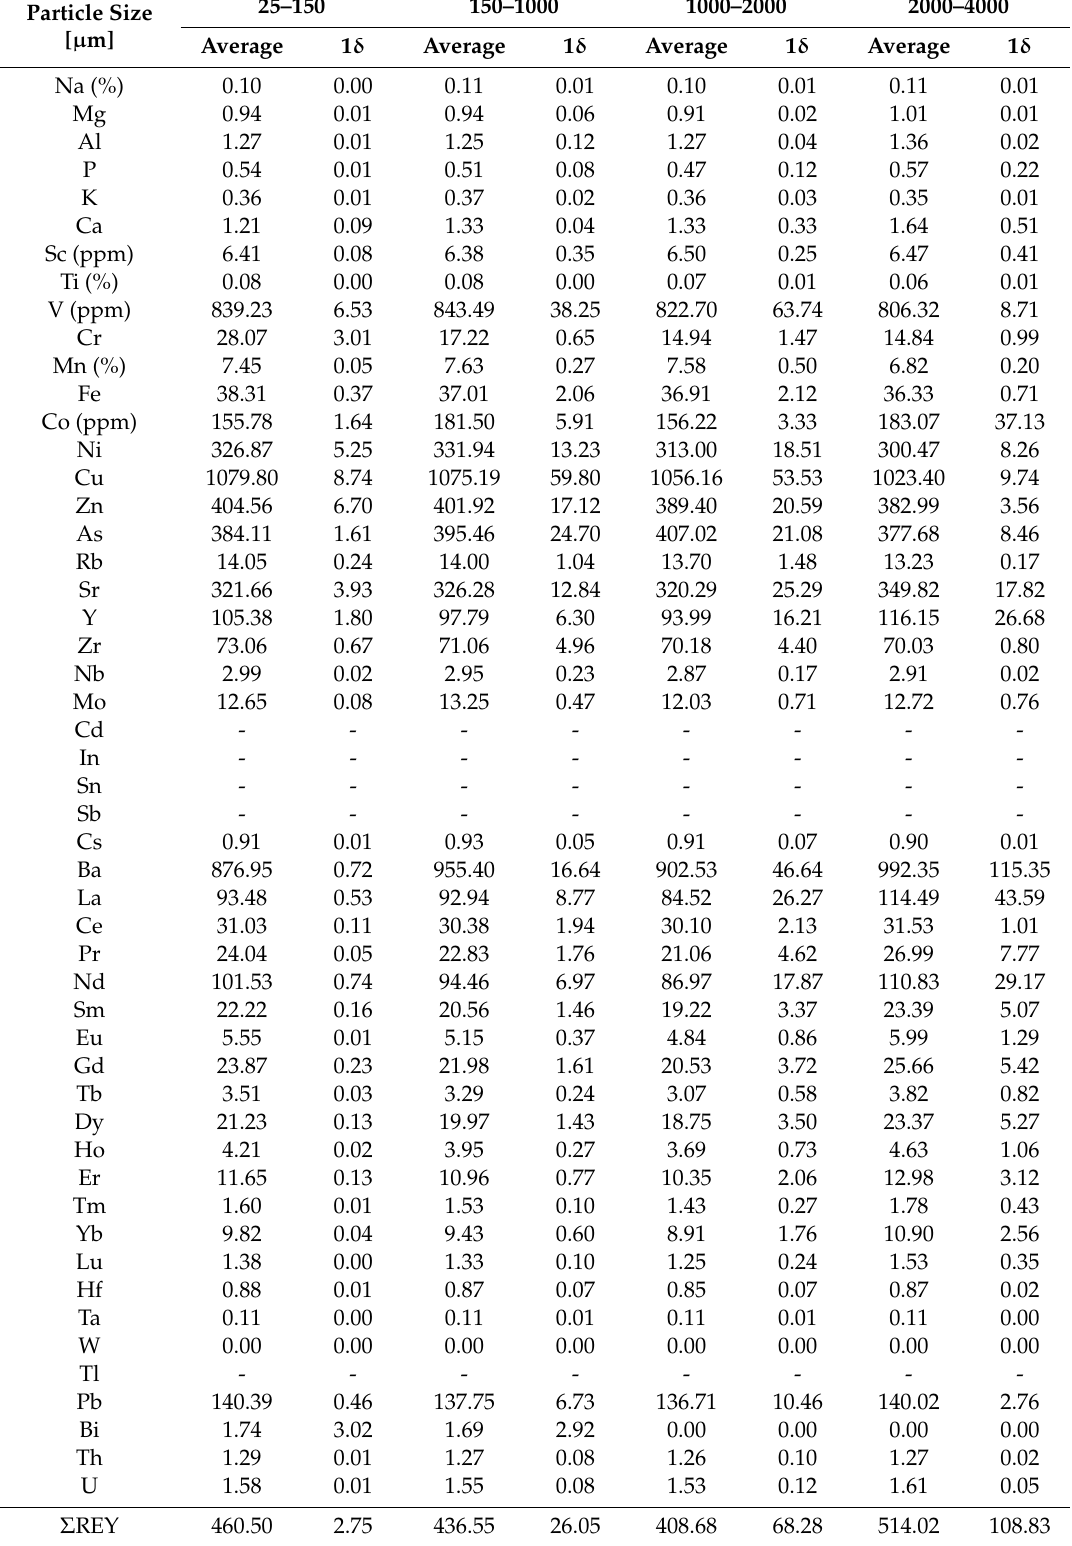
Table 3. Chemical composition of the Cyprus umber determined by